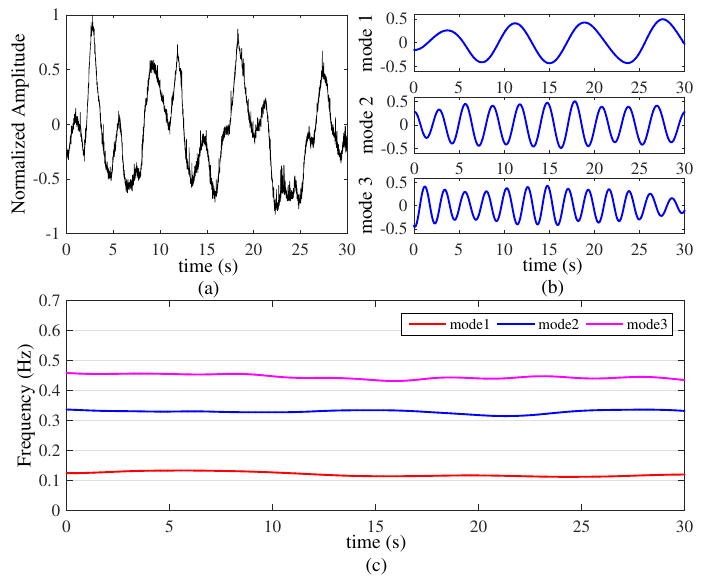
Figure 9. Three targets with constant respiration rates ( k = 4, α = 20,000). ( a ) Original signals; ( b ) three modes decompose by VMD based algorithm; ( c ) time-varying respiration